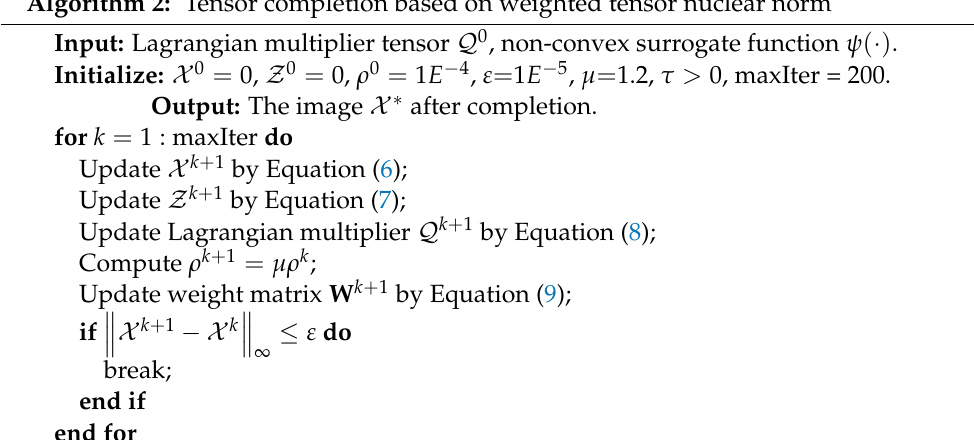
Algorithm 2: Tensor completion based on weighted tensor nuclear